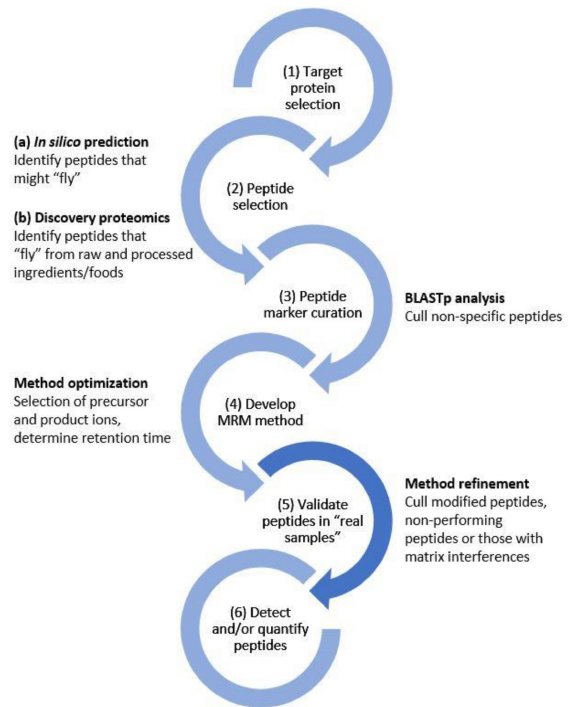
Figure 1. Generic workflow for the development of the LC-MRM-MS method. At each step, potential peptide markers were filtered according to whether they were experimentally detected (step 2), their specificity to the protein(s) of interest (step 3), their performance by LC-MS, the presence of modifications, or matrix e ff ects (steps 4,5). In this study, the emphasis was placed on step (5) to ensure that peptide markers selected from raw ingredients would persist in a diverse set of heavily processed foods. MRM, multiple reaction